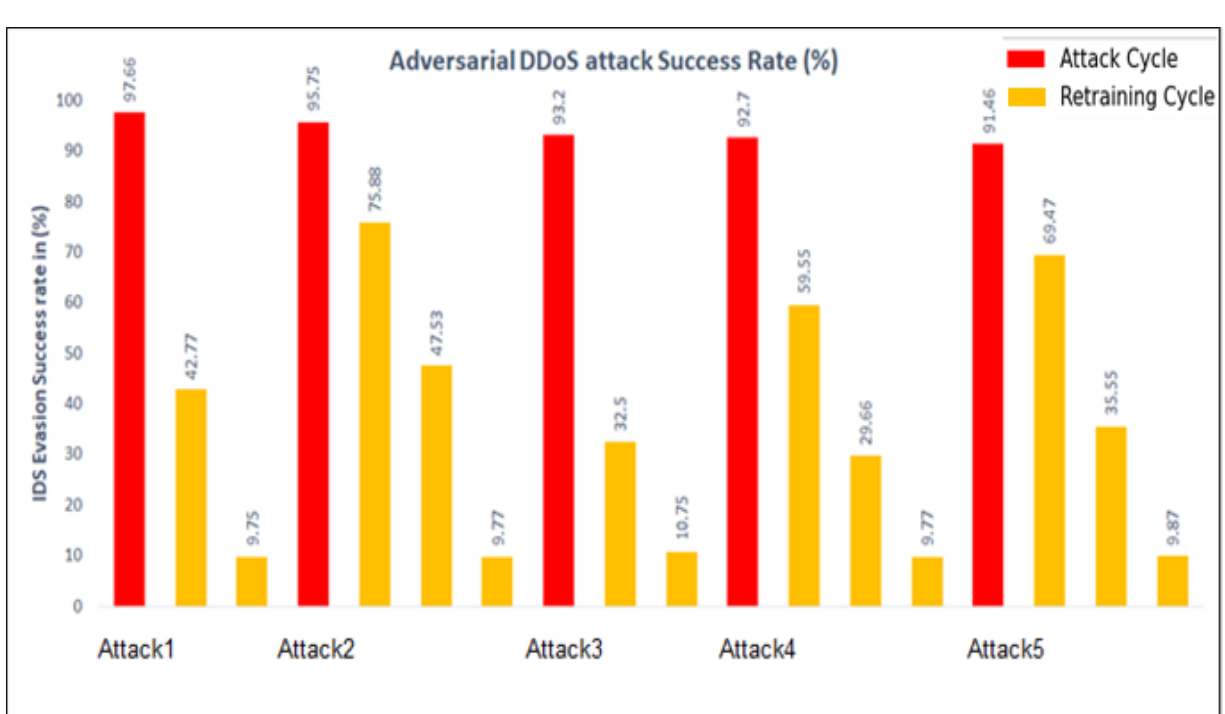
Figure 10. Polymorphic adversarial attacks using the automated feature selection (40 features). 7.2. Analysis and Discussion To evaluate the performance of our WGAN-based framework comprehensively, sev- eral state-of-the-art machine learning models are employed as black-box IDS. The adopted machine learning models include Random Forest (RF), Decision Tree (DT), Support Vec- tor Machine (SVM), K-Nearest Neighbor (KNN), and Naïve Bayes (NB). Multiple IDS models are initially trained using CICIDS2017 data one by one, and then evaluated against adversarial polymorphic attacks using our framework. Figure 11 pro- vides a comparative analysis of these models against adversarial polymorphic attacks. During the first attack cycle, the models are trained using the original training dataset and their performance is evaluated against adversarial attacks. As seen in all of the subfigures above, the adversarial detection rates of all the models are very low in the first phase. For